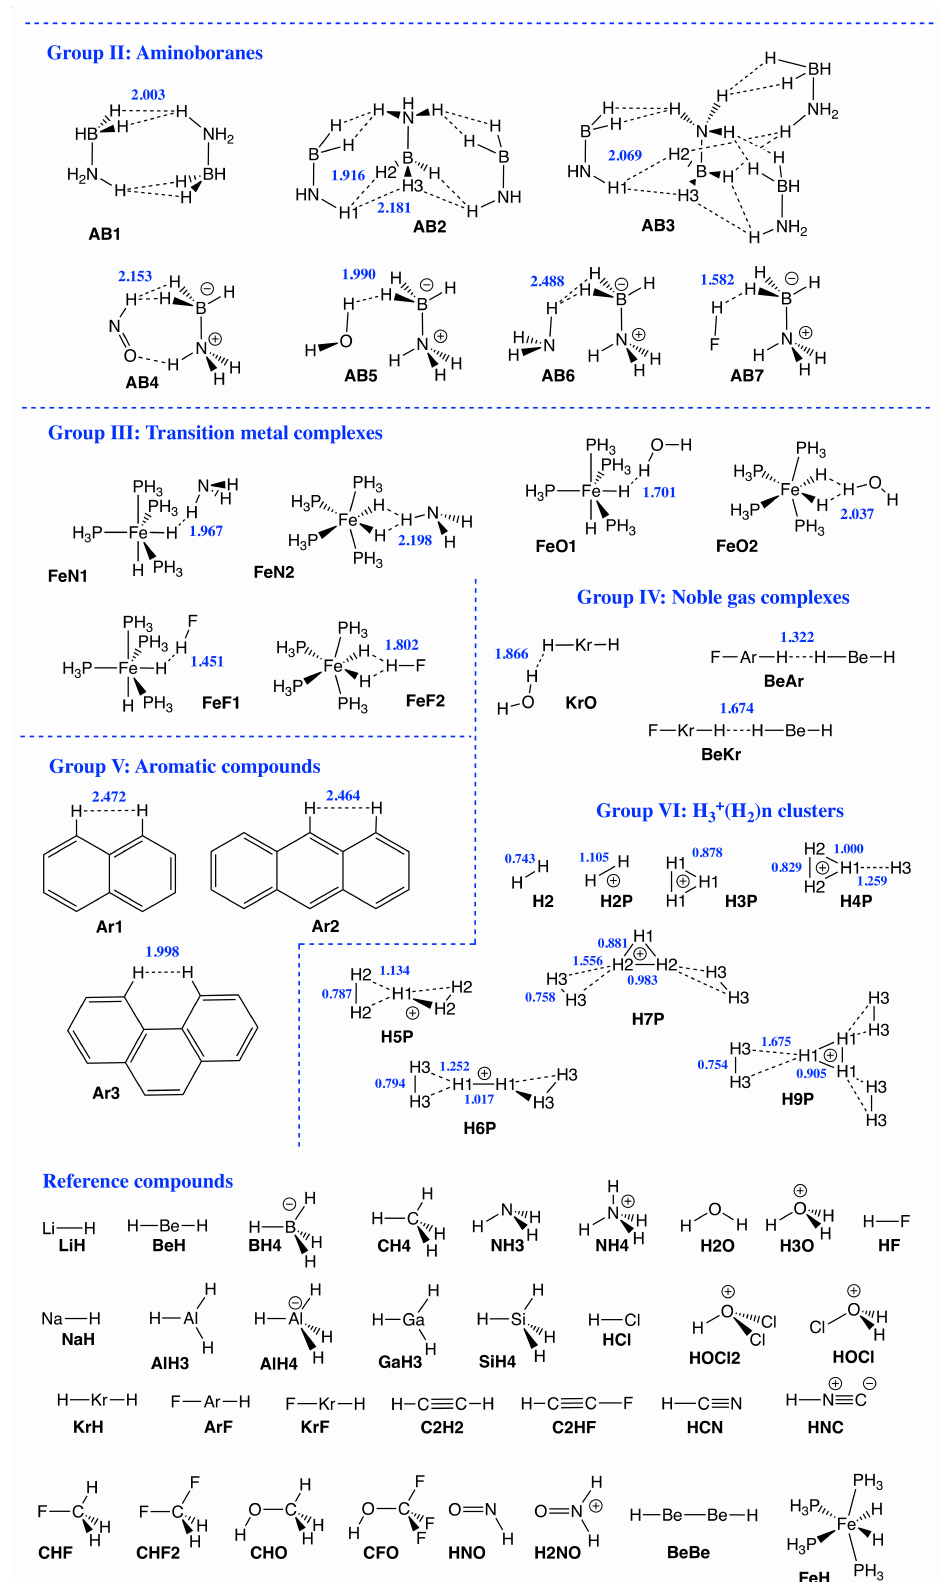
Figure 1. Sketches of Group I–Group VI members and reference compounds investigated in this study. DHB distances (in Å) are given in blue. Short names of the complexes used throughout the manuscript are given in